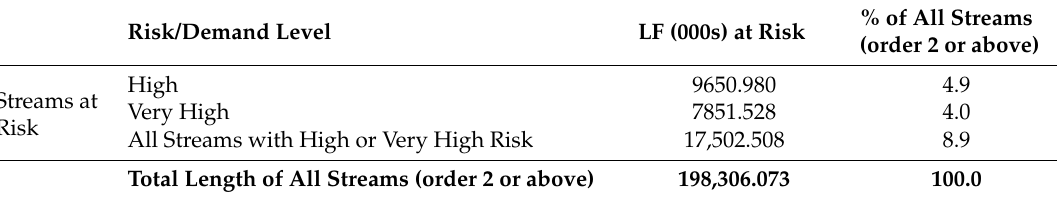
Figure 7. Stream segments with high or very high risk of near-term impacts. Table 8. Summary of stream segments at risk of near-term impacts (000s of LF).